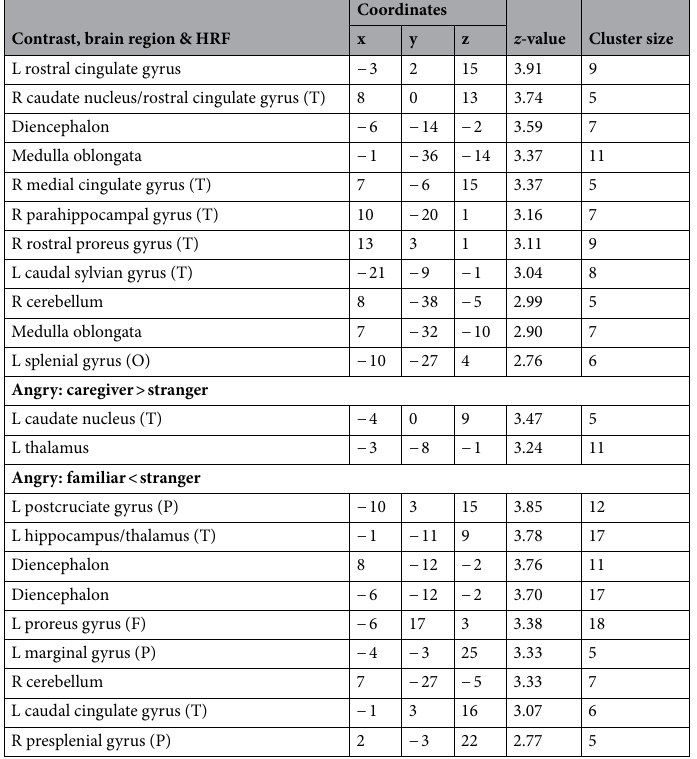
Table 2. Experiment 1 (fMRI), N = 17: Task-related activation during visual stimulation. Effects were tested for significance with a cluster-defining threshold of p < 0.005 uncorrected and a minimum cluster size of 5 voxels. The first local maximum within each cluster is reported; coordinates represent the location of peak voxels and refer to the canine breed-averaged template 65 . The template along with another single dog template 66 served to determine anatomical nomenclature for all tables. Contrasts of interest for the present study are reported; see Supplementary Table S3 for further contrasts on light of full transparency. O occipital lobe, T temporal lobe, P parietal lobe, O occipital lobe, L left, R right.